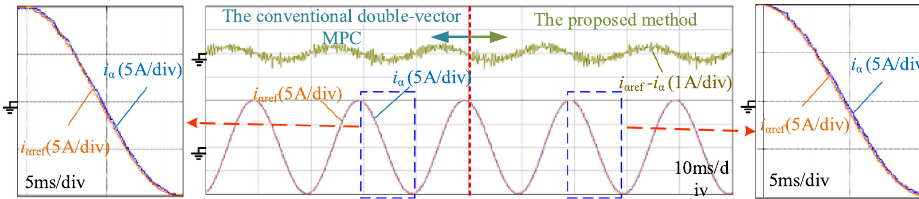
Fig. 14. Comparison of current errors when the reference current is 10 A.